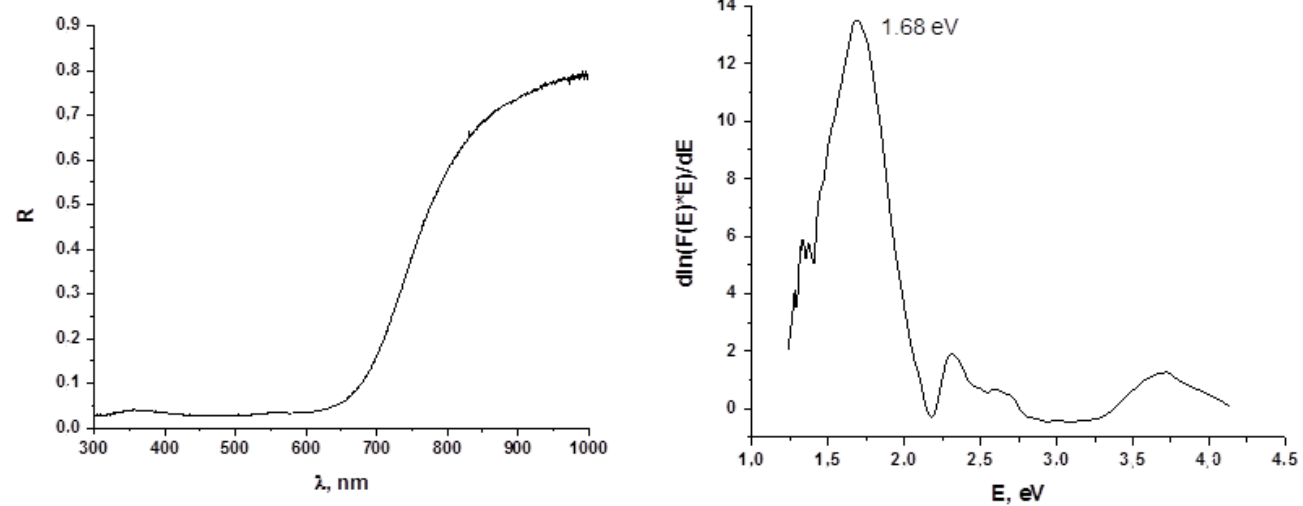
Figure 6. Diffuse reflectance spectrum ( left ) and optical band gap determination (Tauc coordinates, right ) for 1 .